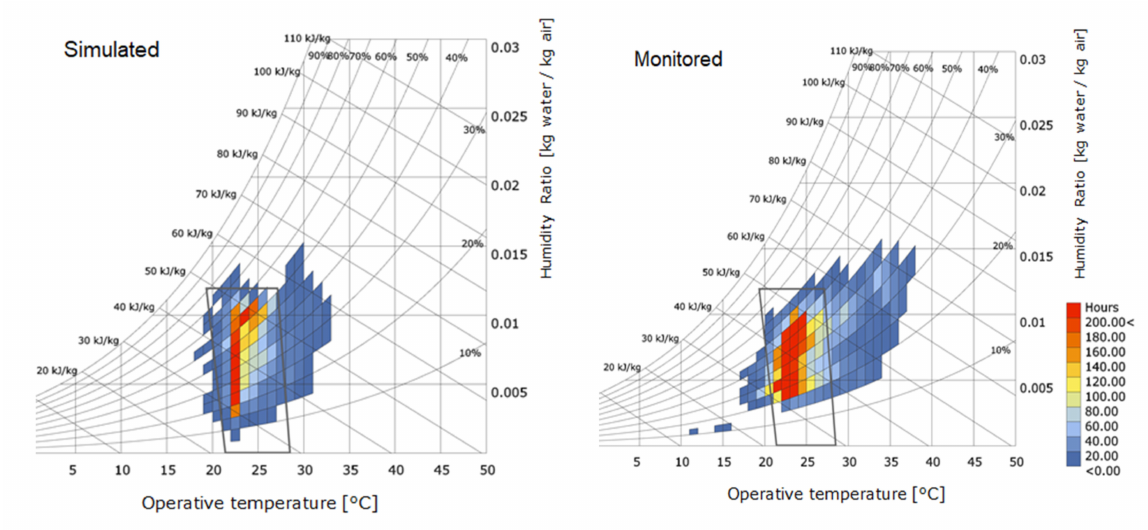
Figure 8. Yearly psychrometric diagrams for the simulated ( left ) and the monitored scenario ( right ). The comfort polygon is highlighted in the center of the